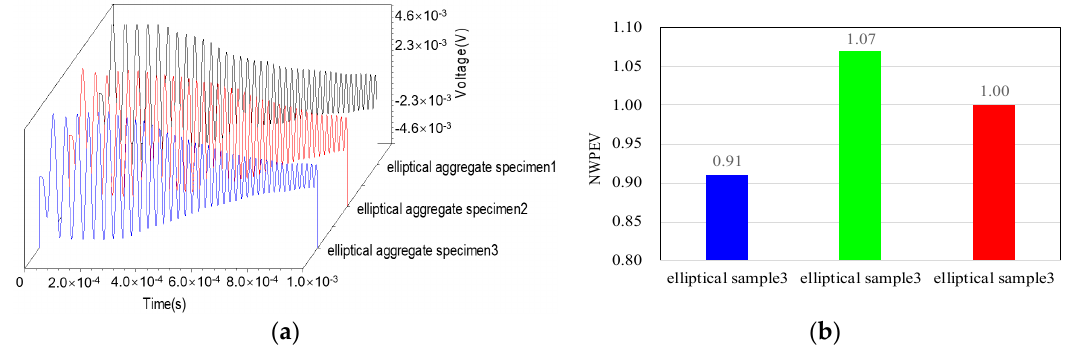
Figure 10. Output voltage and NWPEVs with different aggregate distribution. ( a ) Time–history curves of the output voltage; ( b ) Normalized wavelet packet energy value.